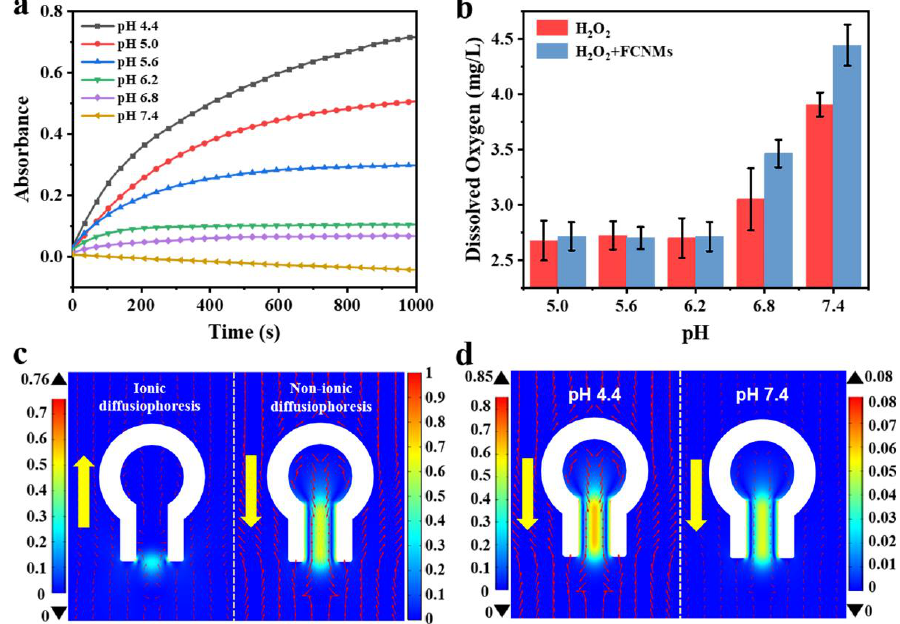
Figure 4. Verifications of propulsion mechanisms of the FCNMs through experiments and numerical simulations. ( a ) UV-Vis absorption-time course curves at 650 nm of the TMB-H 2 O 2 system with the FCNMs at different pH values. ( b ) Dissolved oxygen analysis of the H 2 O 2 system with or without the FCNMs at different pH values for 10 min. ( c ) Flow fields caused by ionic and non-ionic concentration gradient around the FCNMs at pH 4.4, respectively, where the small red arrows refer to the relative strength of flow velocity and the large yellow arrows refer to the direction of motion. ( d ) Total flow fields around the FCNMs at pH 4.4 and 7.4, respectively.